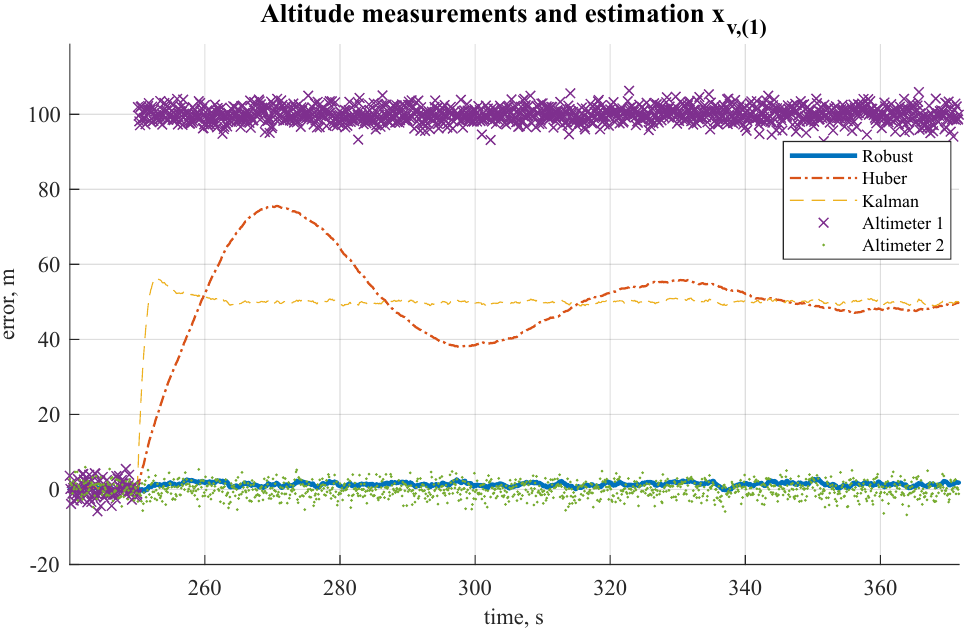
Figure 8. Filter response to step error in backup altimeter measurements. «Robust»—the proposed robust algorithm. «Huber»—M